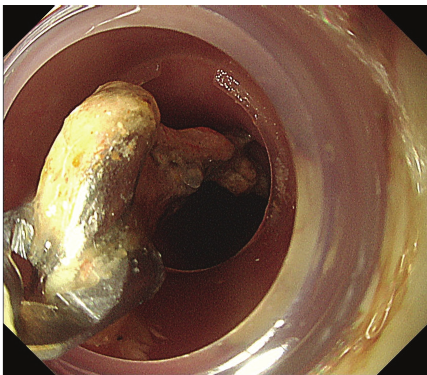
Figure 2: Retrieval of the partial denture using grasping forceps and a distal